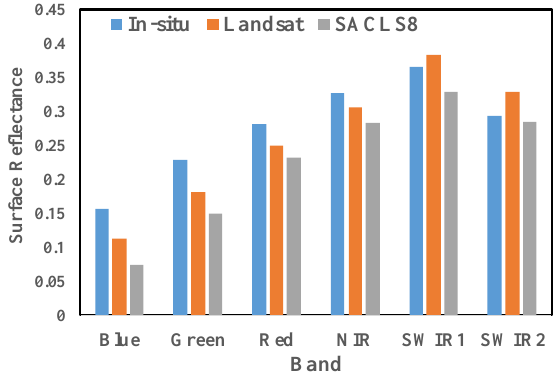
Figure 4: Comparison of Landsat-8 and SACLS8 surface reflectance with in-situ